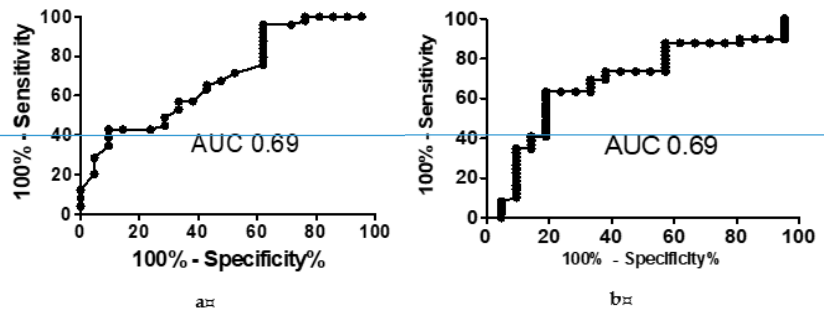
Figure 1. ROC (receiver operating characteristic) curve and AUC (area under the curve) value for ICT (inhibitory control test) in the diagnosis of MHE (minimal hepatic encephalopathy). ( a ) for the rate of incorrect responses, ( b ) for the lures / target accuracy